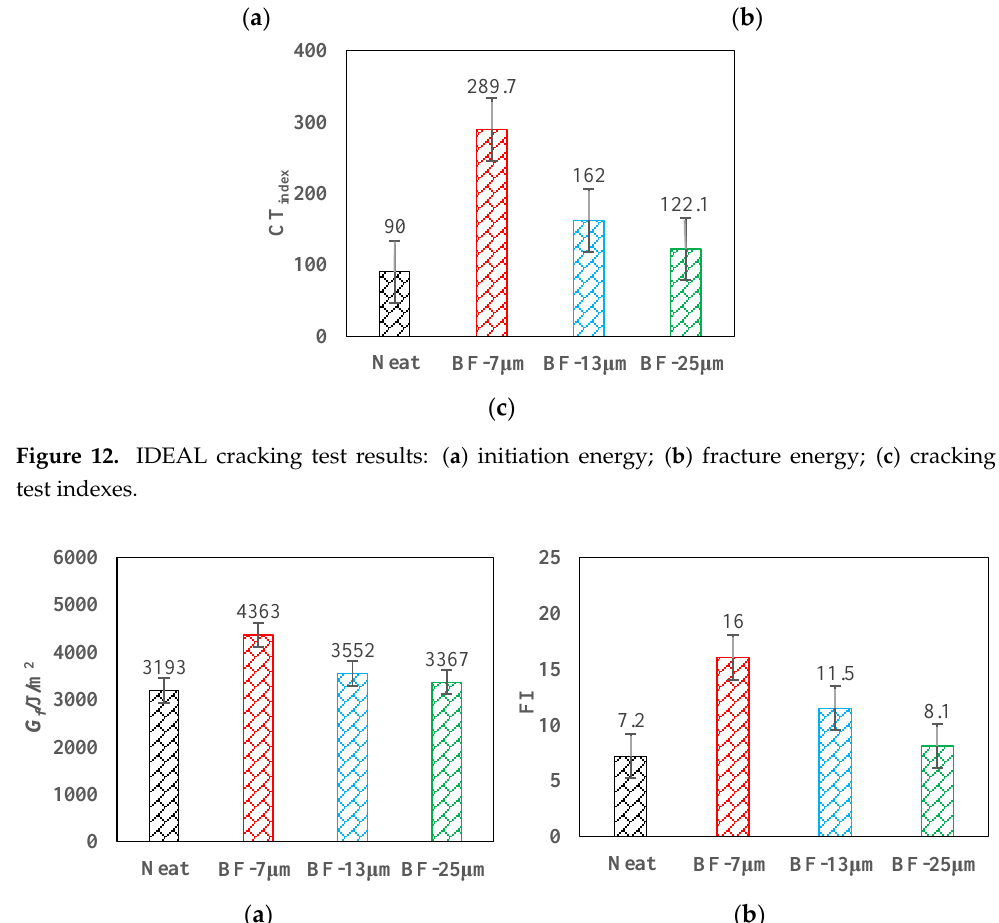
Figure 12. IDEAL cracking test results: ( a ) initiation energy; ( b ) fracture energy; ( c ) cracking test indexes.